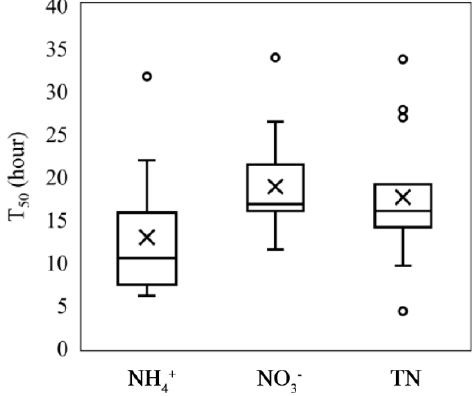
Figure 6. T 50 of NH 4 + , NO 3 − , and TN in SZ during dry periods. In each box, the five short lines “-” represent the upper limit value, upper quartile value, median value, lower quartile value, and lower limit value of the data, respectively; the points “x” and “ ◦ ” represent the mean value and the outlier value of the data, respectively.